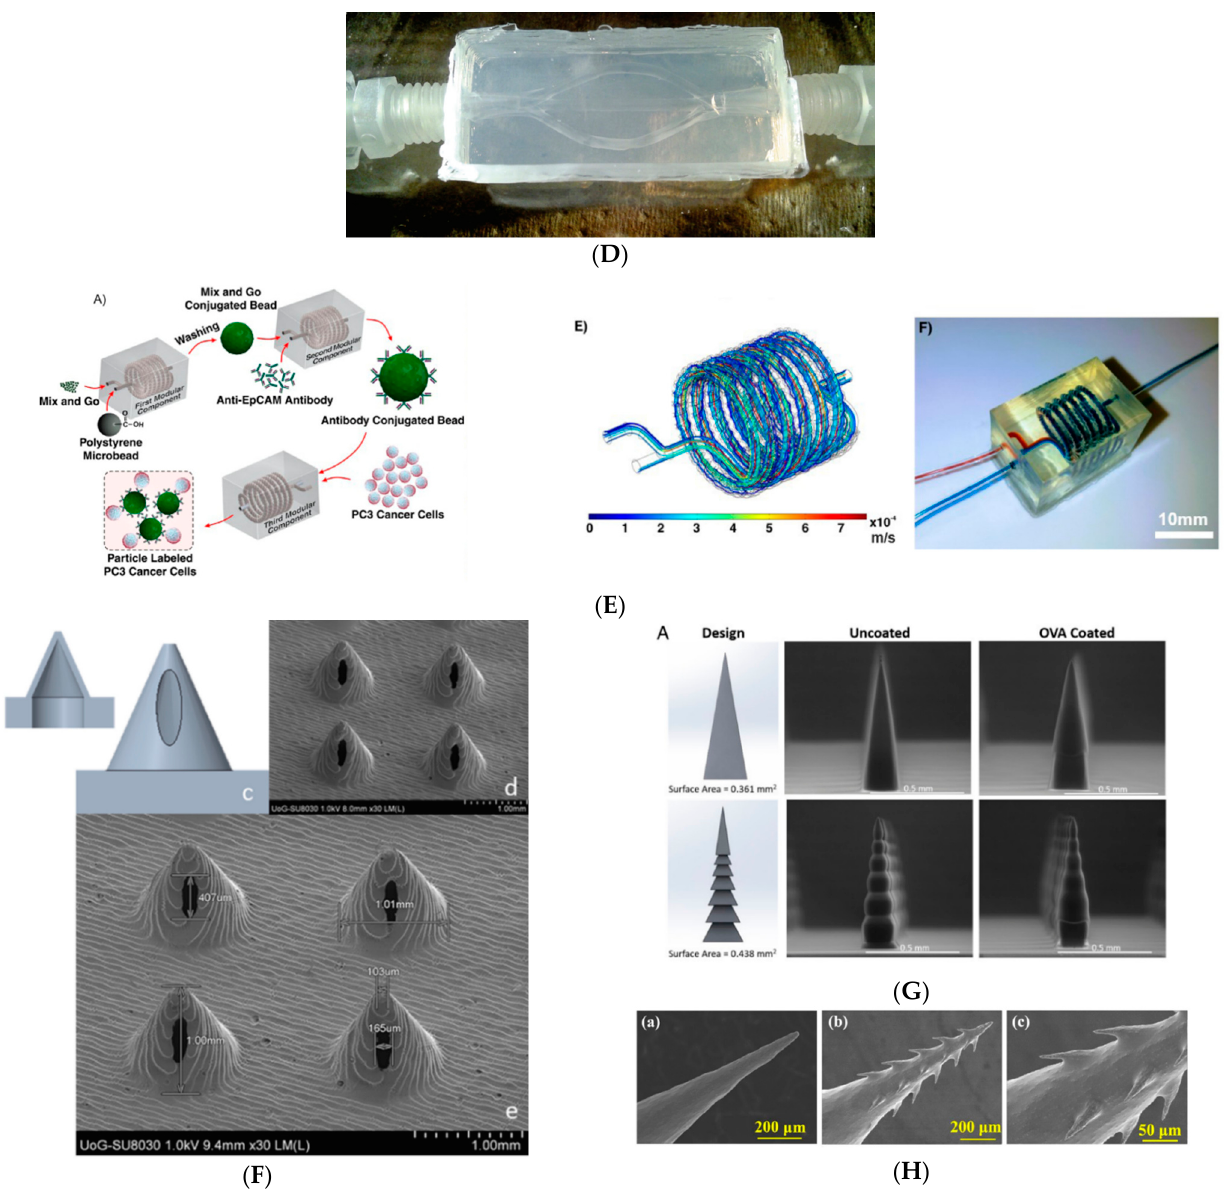
Figure 3. Examples of biomedical devices: drug delivery applications, microchannels, and microneedles: ( A ) Presentation of the operation of the multi-material soft robot. Movement of the actuator inside an anatomical stomach model with cancer tissue (target) and release of the drug at